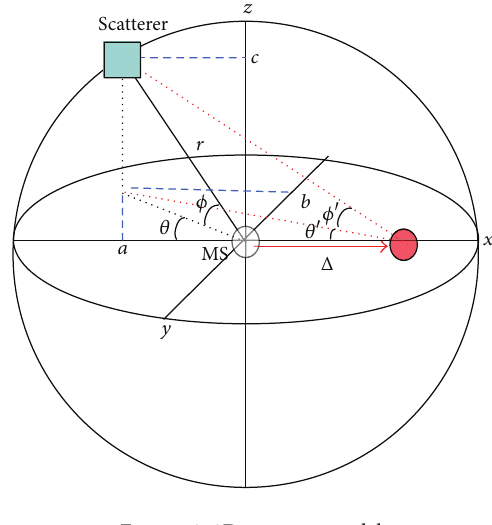
Figure 1: 2D scatterer model. Figure 2: 3D scatterer model.